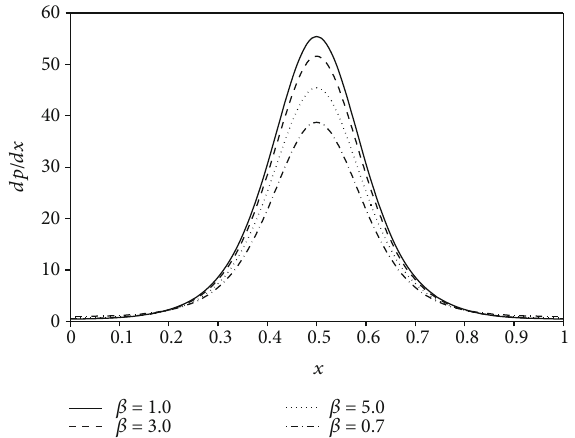
Figure 7: Variation of pressure gradient with x for di ff erent values of φ for fi xed values of n = 0 : 5 , β = 4 , We = 0 : 6 , and Q = − 1 .